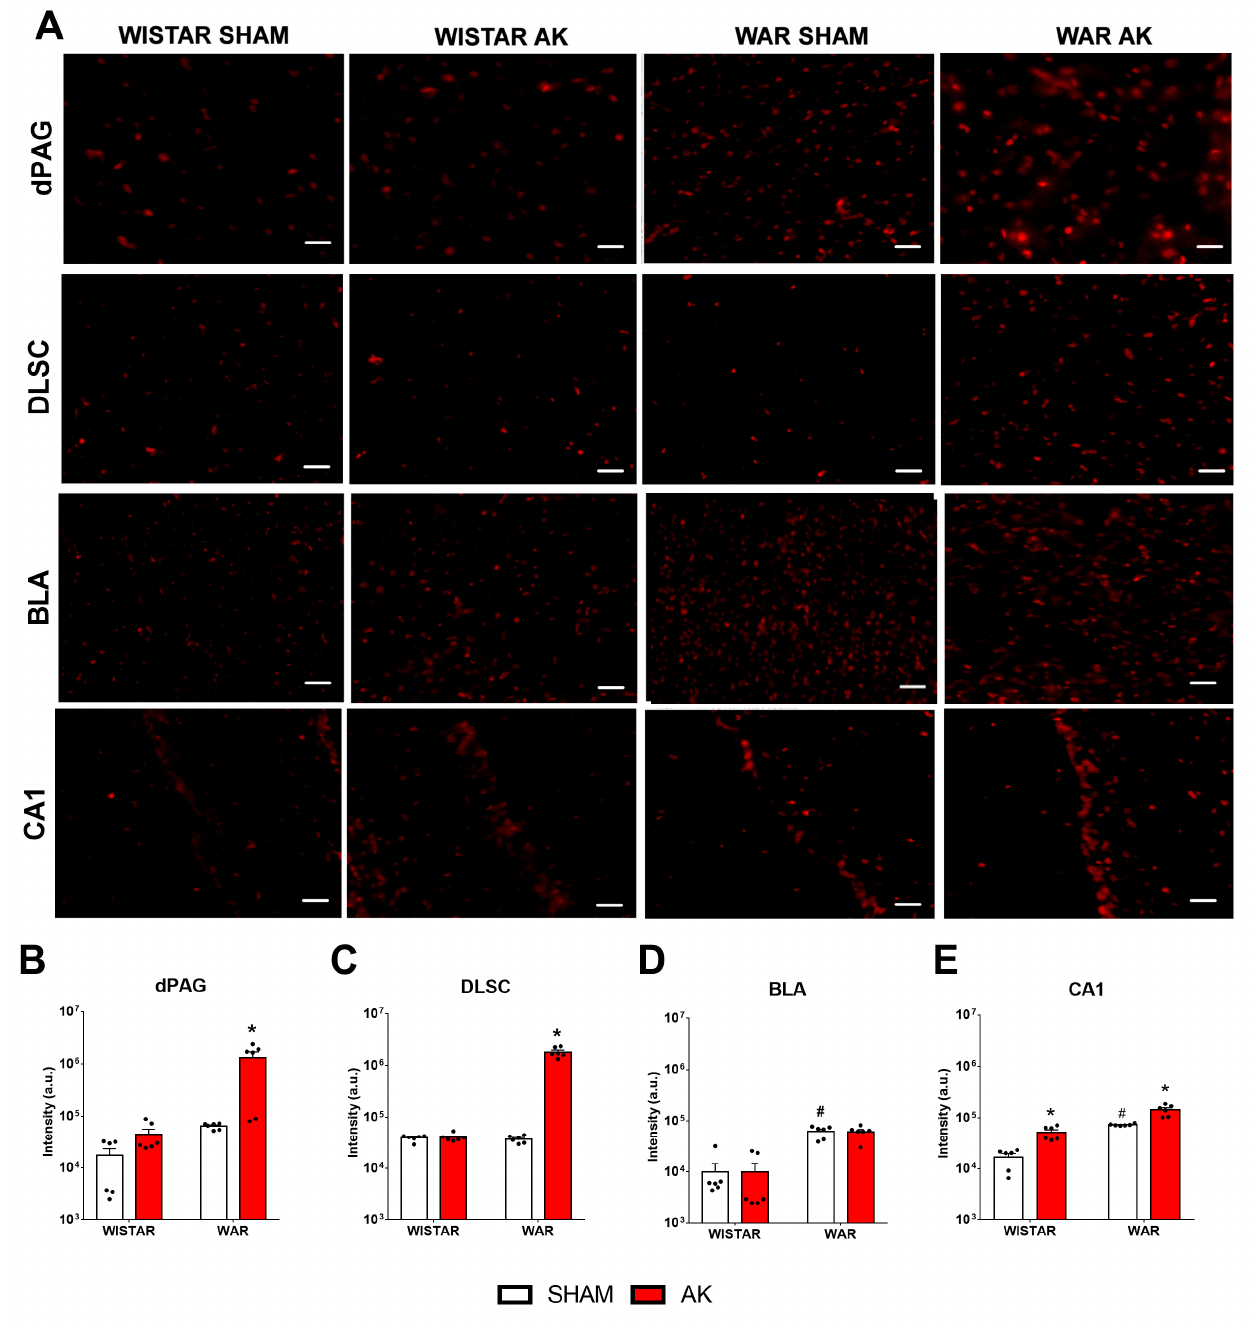
Figure 6. Immunofluorescence for TRPV1 channels after the audiogenic kindling (AK) protocol. ( A ) Representative images of every analyzed area in each experimental group. ( B ) dorsal periaqueduc ‐ tal gray matter—dPAG. ( C ) deep layers of superior colliculus—DLSC. ( D ) basolateral amygdala nucleus—BLA. ( E ) CA1 area of the dorsal hippocampus. # p < 0.05 Tukey test compared to Wistar ‐ Sham. * p < 0.05 Tukey test compared to WAR ‐ Sham. N = 6 animals/group. Scale bars = 200 μ m.